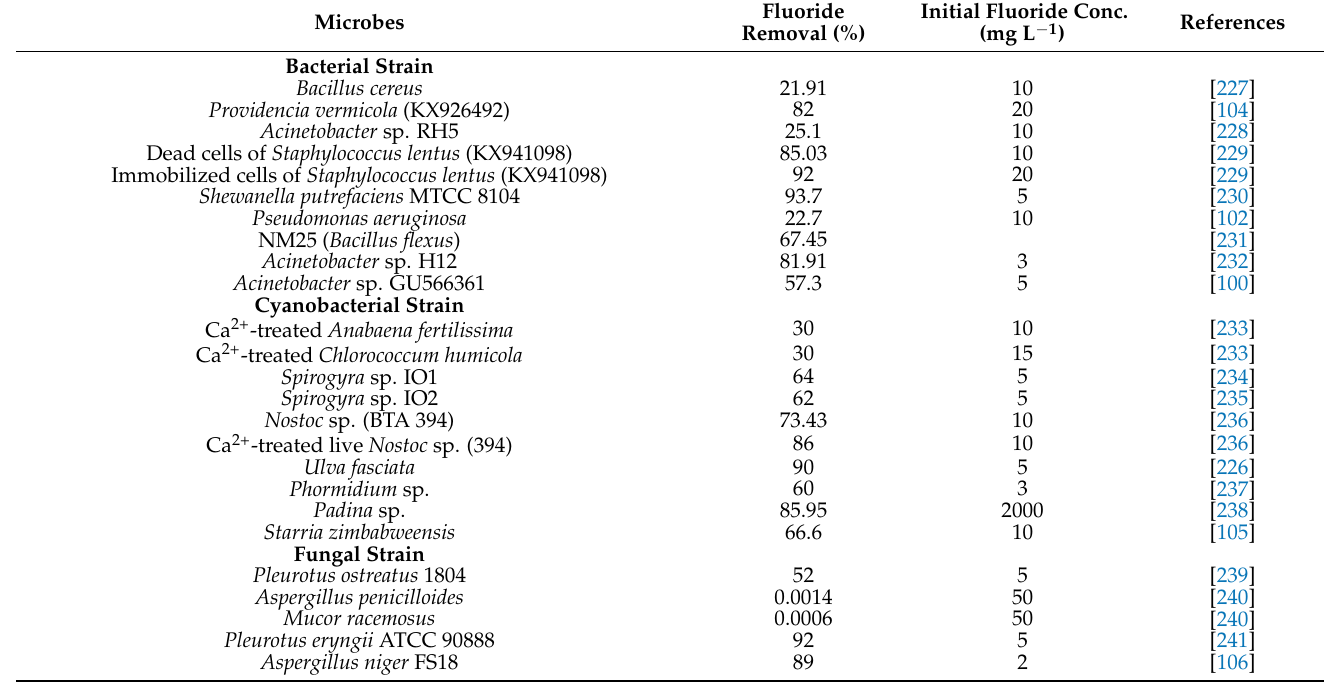
Table 2. Fluoride removal using microbial-based